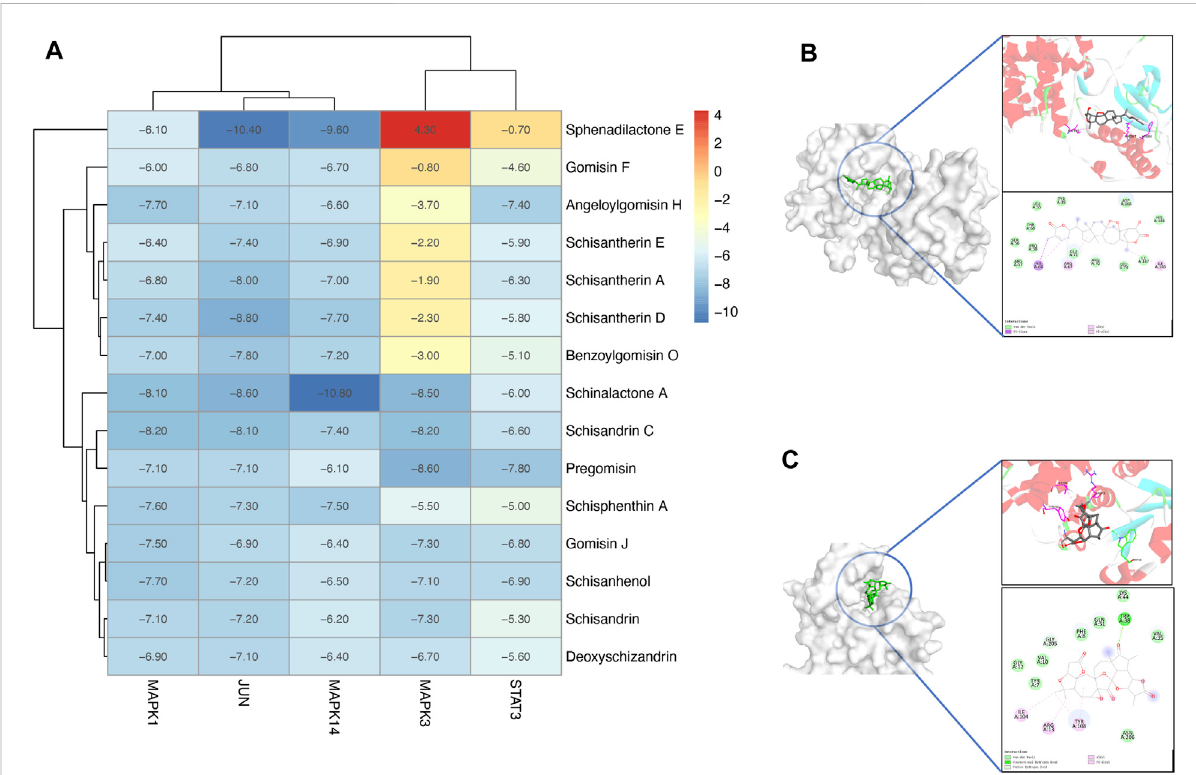
FIGURE 8 Molecular dockinganalysis ofthe PEF against asthma. (A) Heatmap of molecular docking analysis. (B) MAPK14 (PDB ID: 5WJJ)-Schinalactone A ( − 10.8 kcal/mol). (C) JUN (PDB ID: 5J41)-Sphenadilactone E ( − 10.4